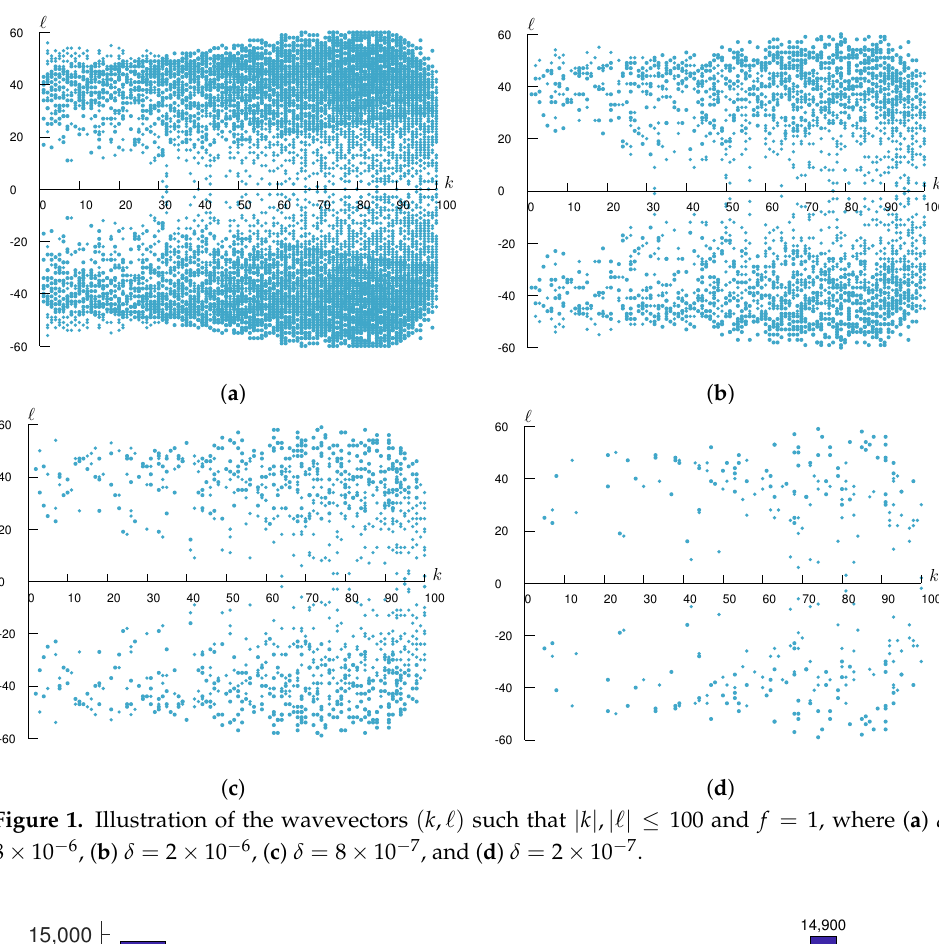
Figure 1. Illustration of the wavevectors ( k , (cid:96) ) such that | k | , | (cid:96) | ≤ 100 and f = 1, where ( a ) δ = 8 × 10 − 6 , ( b ) δ = 2 × 10 − 6 , ( c ) δ = 8 × 10 − 7 , and ( d ) δ = 2 × 10 − 7 .